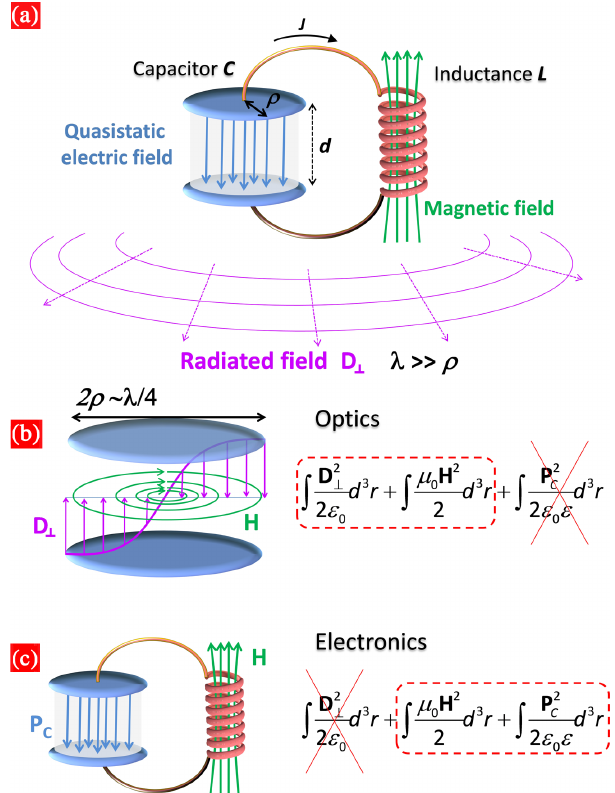
FIG. 1. (a) General illustration of an LC circuit, indicating the quasistatic electric field inside the capacitor and the radiated field far away from the system. We have considered a circular plate capacitor of radius ρ . (b,c) Relevant terms of the electrodynamic Hamiltonian that describes the system, either as a high-frequency photonic resonator (b) or a low-frequency circuit resonator